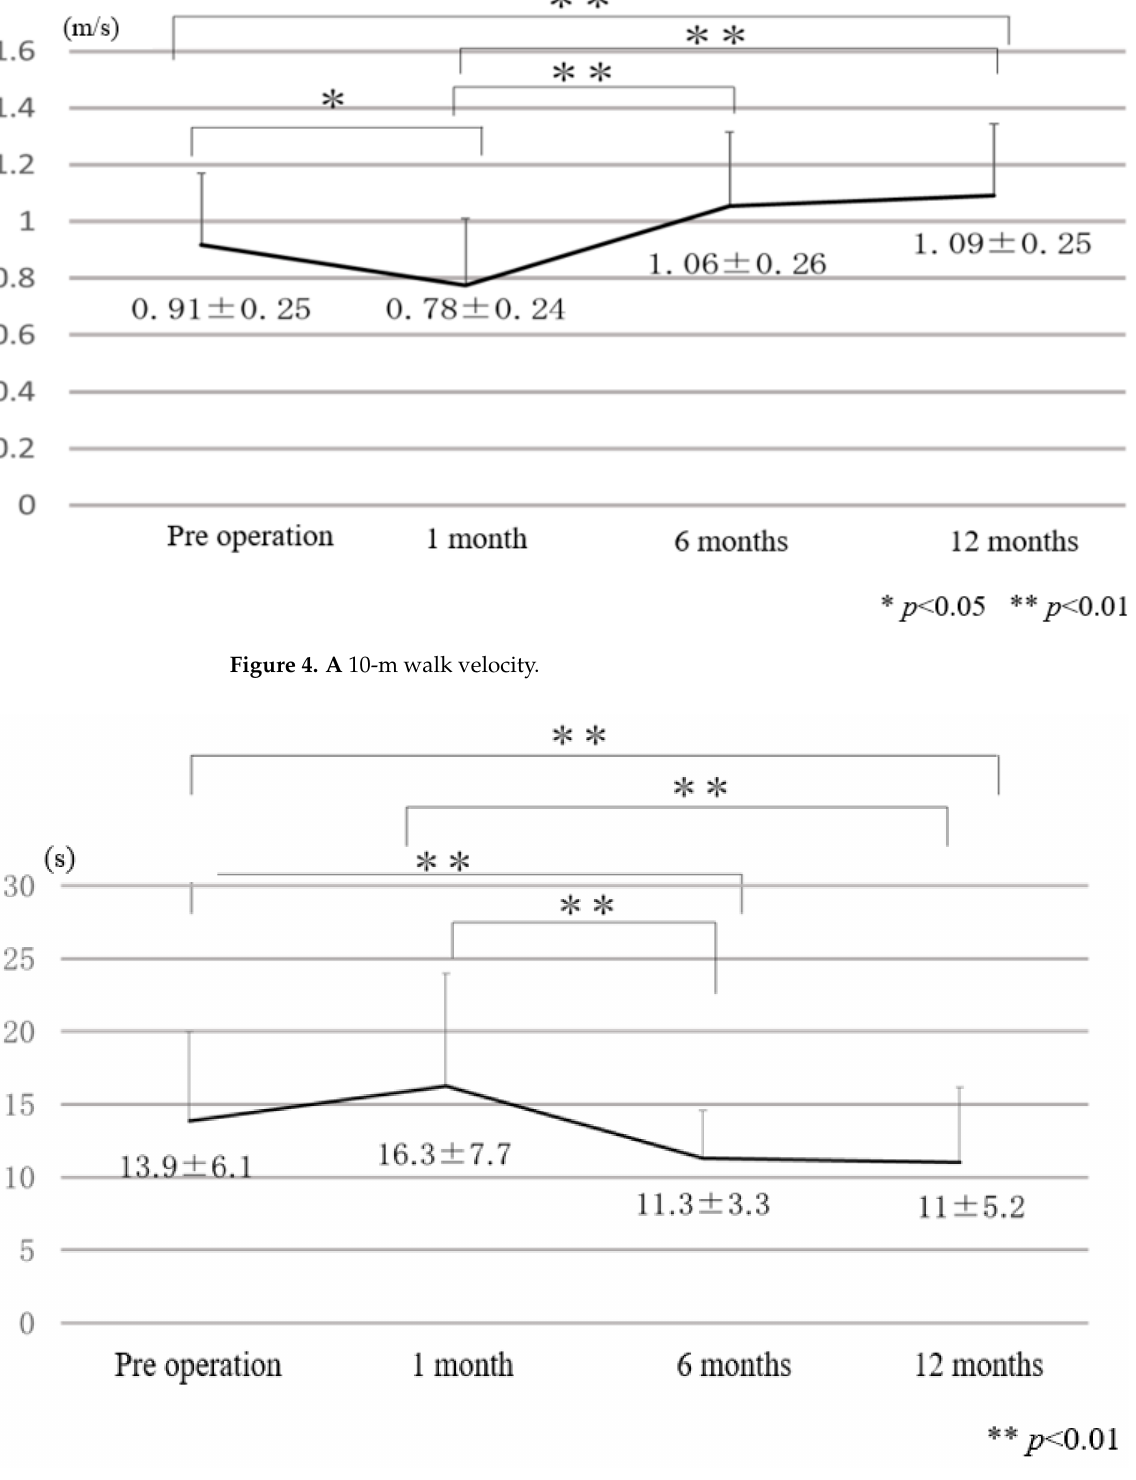
Figure 5. Timed up and go test.